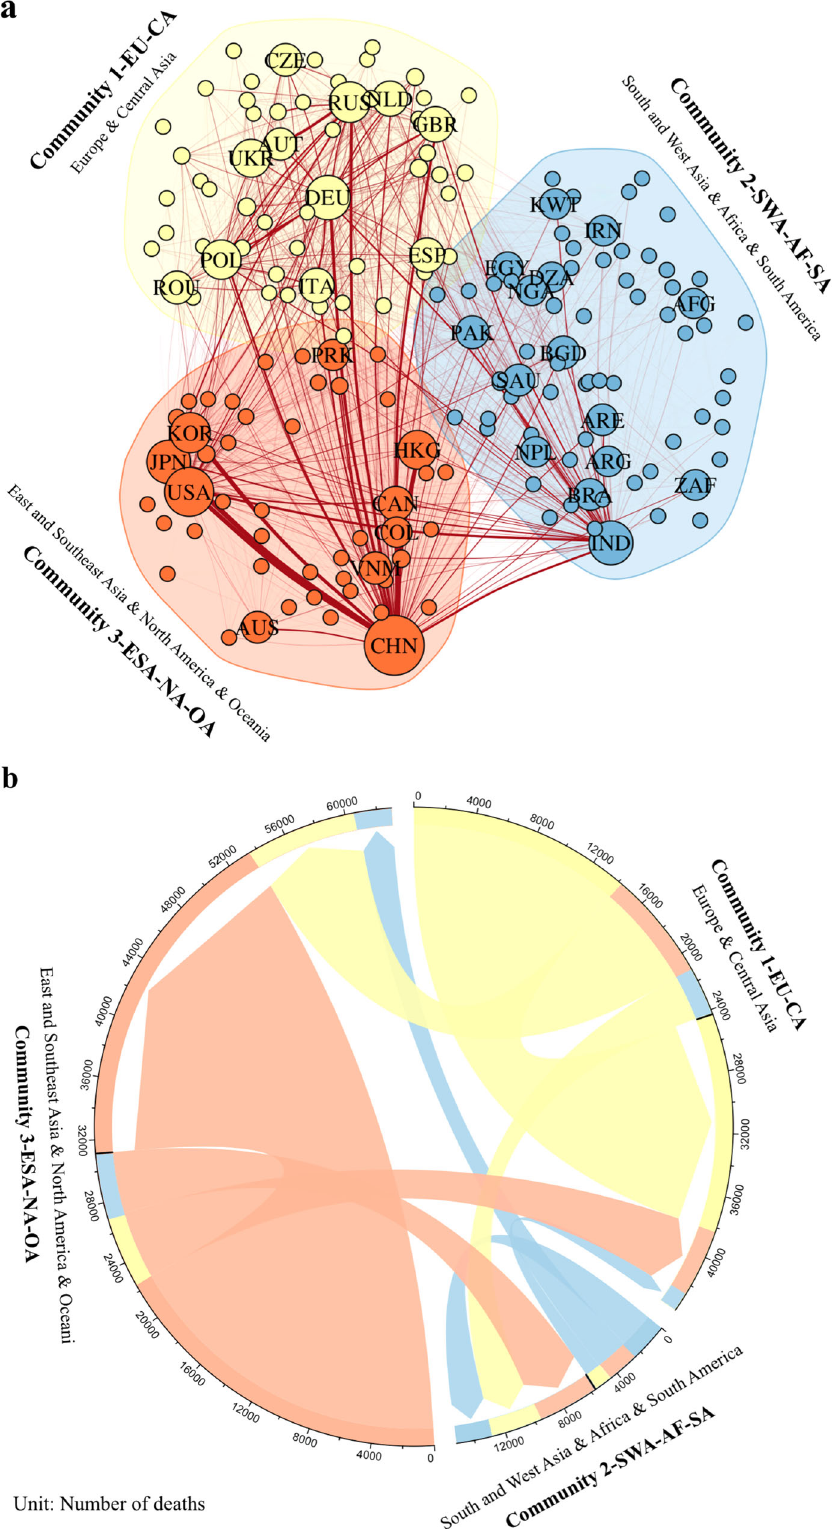
Fig. 3 Regional communities of NH 3 trade-related health-effect network. a The partitions of communities. Along with each community, the major hub economies are also indicated. The size of a circle represents the relative trade-related health loss. The width of a connecting line between two circles represents the relative health loss attributed to the trade between the two nodes. b The intracommunity and intercommunity health-effect fl ows (number of deaths). Community 1-EU-CA (in yellow) is mainly formed by countries in Europe and Central Asia; Community 2-SWA-AF-SA (in blue) consists of countries in South and West Asia, Africa, and South America; Community 3-ESA-NA-OA (in orange) is dominated by countries in East and Southeast Asia, North America and Oceania. The width of the connecting line represents trade-related health loss. The three-letter country abbreviations inserted in the plot are detailed in Supplementary Data 6. Supplementary Fig. 6 shows the geographical distributions of